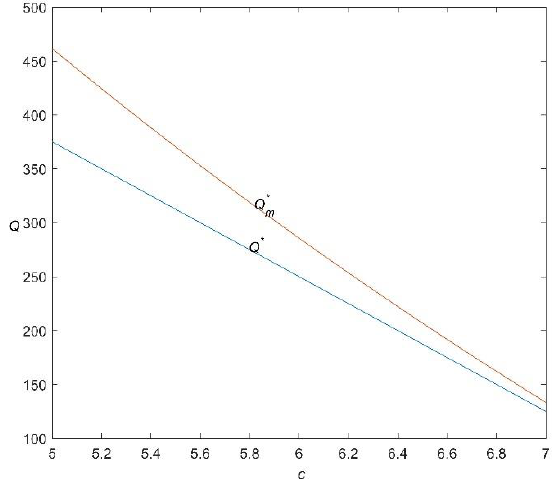
Figure 1. Optimal purchase quantity Q ∗ and Q ∗ m under different wholesale prices c .